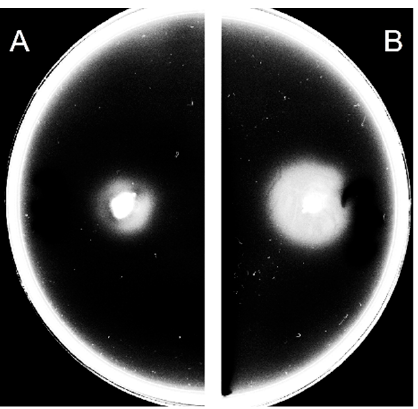
Figure 1. The swarming motility of C. jejuni 11168-O following 24 h incubation. ( A ) Wild type cells. ( B ) Wild type cells mixed with 200 μ M of ex-c-di-GMP.